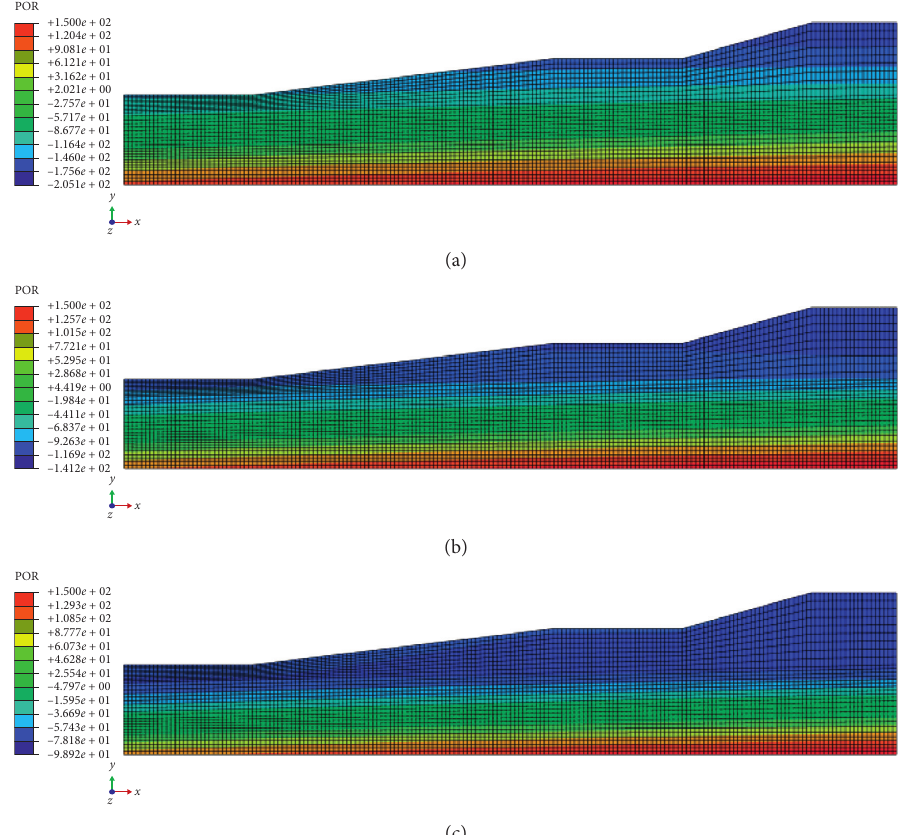
Figure 5: Distributions of pore pressure under different rainfall intensities. (a) Rainfall intensity is 40mm/d. (b) Rainfall intensity is 80mm/d. (c) Rainfall intensity is